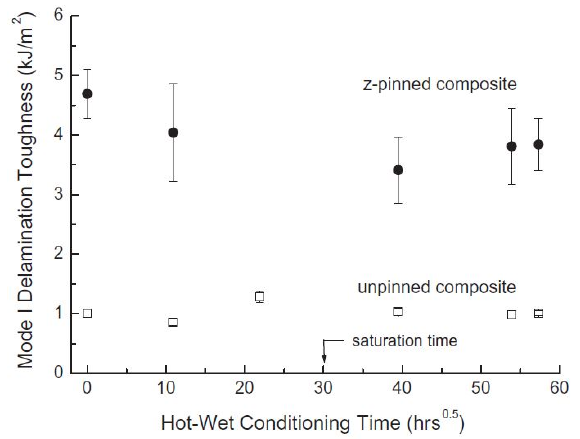
Figure 69. E ff ect of z-Pin content on compressive strength in quasi-isotropic laminates in both RTD environment and Hygrothermal environment [42].